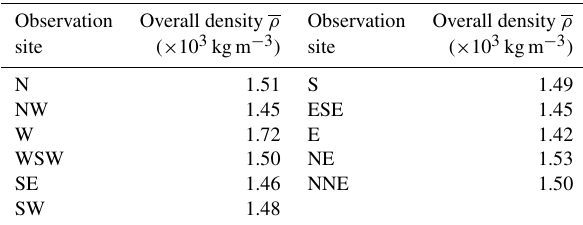
Table 2. Overall bulk density obtained by muography, assuming that the density is uniform in the volcanic